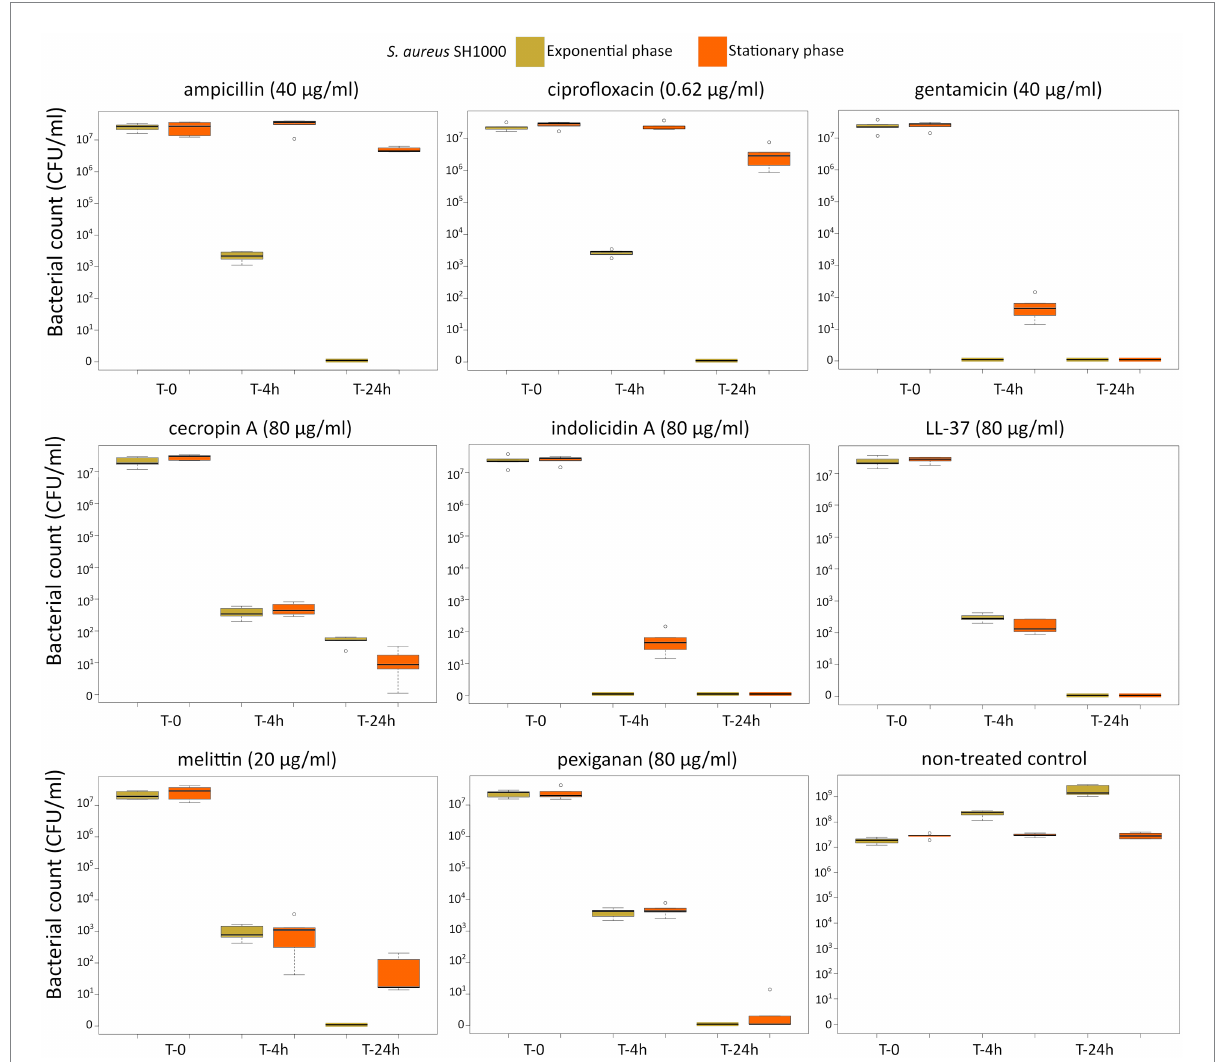
FIGURE 2 Killing of Staphylococcus aureus SH1000 at 10× MIC for five antimicrobial peptides and three different antibiotics. The yellow light green boxes indicate bacteria growing exponentially while the orange ones denote treated bacteria in the stationary phase in spent medium prepared as described in the Materials and methods section.